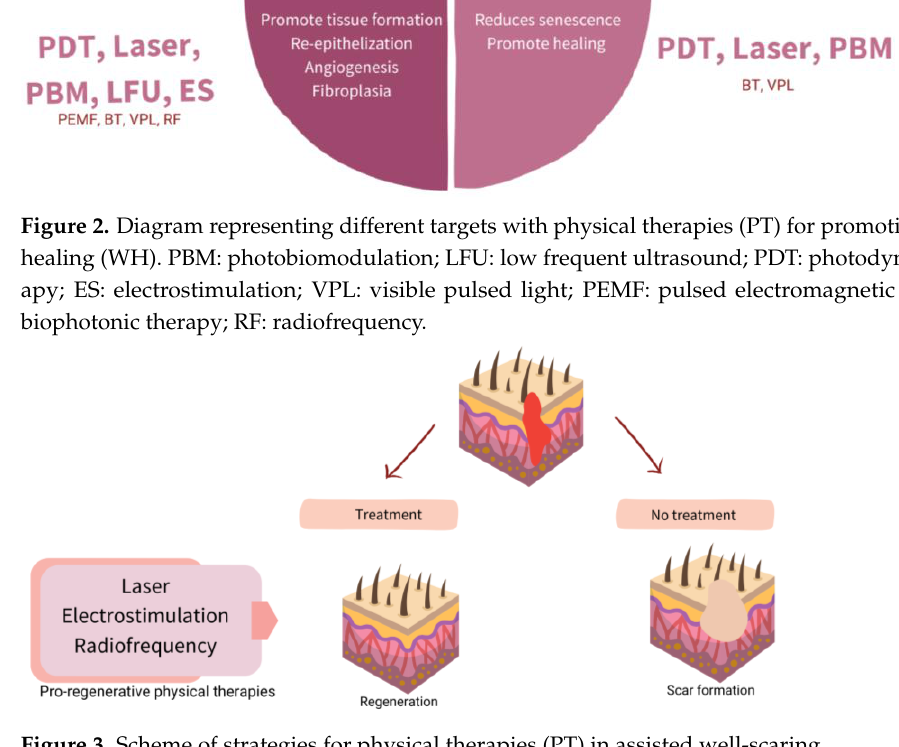
Figure 3. Scheme of strategies for physical therapies (PT) in assisted